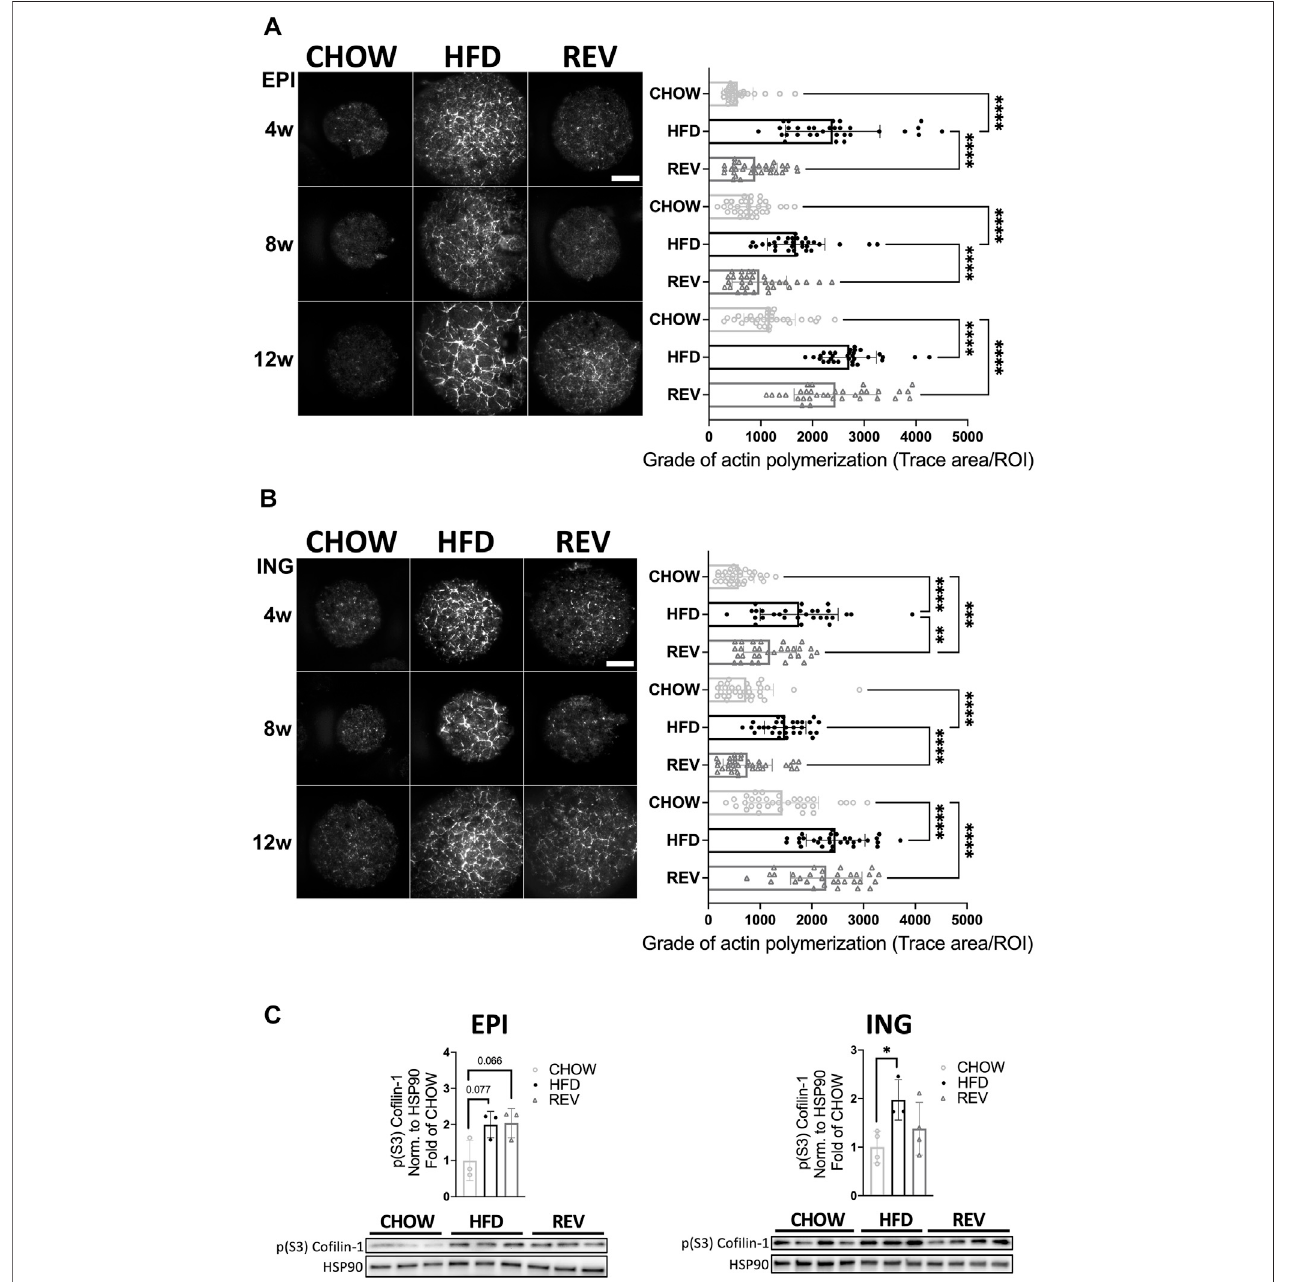
FIGURE 5 | Time resolved analysis of actin polymerization in primary adipocytes following diet intervention. TIRF microscopy of primary adipocytes isolated from EPI (A) and ING (B) fat depot stained with phalloidin to detect fi lamentous actin. Representative images (left panel) from CHOW, HFD and REV during 4w, 8w, or 12w of dietintervention,andcorrespondingquanti fi cation(rightpanel)foreachtimepoint, n =29 – 35cells/condition. (C) Westernblotanalysisandcorrespondingquanti fi cation ofphosphorylated(S3)Co fi lin-1inlysatesfromEPI(leftpanel)andING(rightpanel)adipocytesafter12wofdiet.ValuesareexpressedasfoldofCHOWandHSP90 was used as a loading control. Data are displayed as mean±SD. One-way ANOVA, Tukey ’ s post-hoc test, was used as statistical analysis of differences between CHOW, HFD and REV for each time point (4, 8, and 12w). Signi fi cance was determined according to * p ≤ 0.05, ** p ≤ 0.01 and *** p ≤ 0.001.